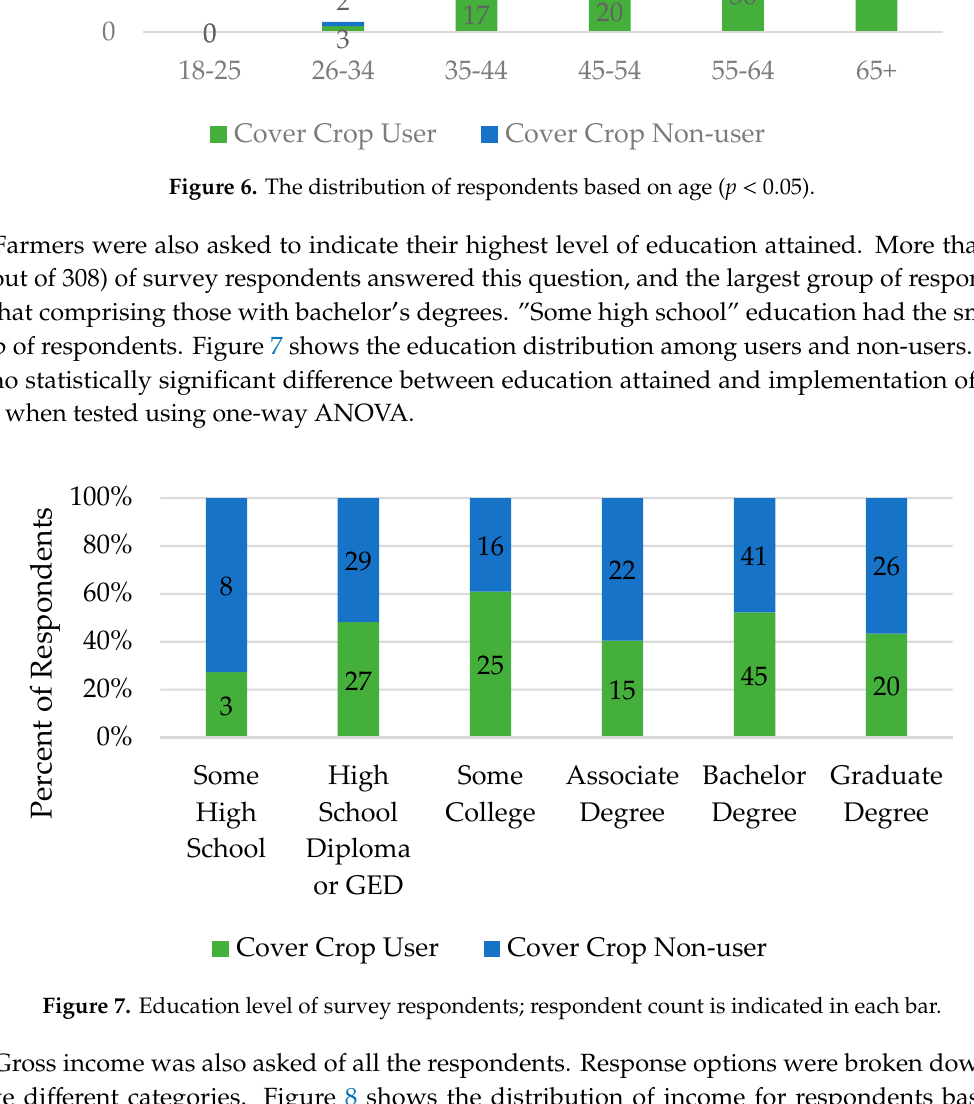
Figure 7. Education level of survey respondents; respondent count is indicated in each bar. Gross income was also asked of all the respondents. Response options were broken down into twelve di ff erent categories. Figure 8 shows the distribution of income for respondents based on whether they used cover crops or not. A one-way ANOVA test showed that income is significant when considering whether farmers will implement cover crops or not. The analysis indicates that those with a higher income were more likely to implement cover crops. Furthermore, farm size and income level were highly correlated ( p < 0.05) in a one-way ANOVA